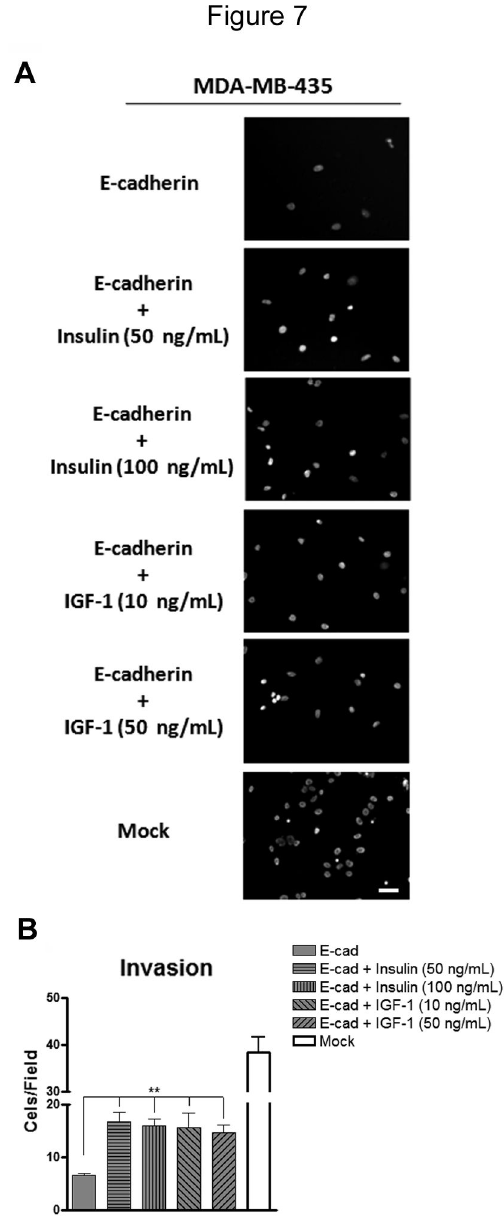
Figure 7. Effects of stimulation with insulin and IGF-I on cell invasion. Representative images of cell invasion through Matrigel using 8 mm pore of a polycarbonate membrane. Nuclei were stained with DAPI. We observed a significant increase of tumor cell invasion of MDA-MB-435+Ecad after stimulation with insulin or IGF-I. The bar graph shows the amount of cells/field. Error bars indicate the means + S.E.M. (n = 3). ** = P < 0.01 ANOVA